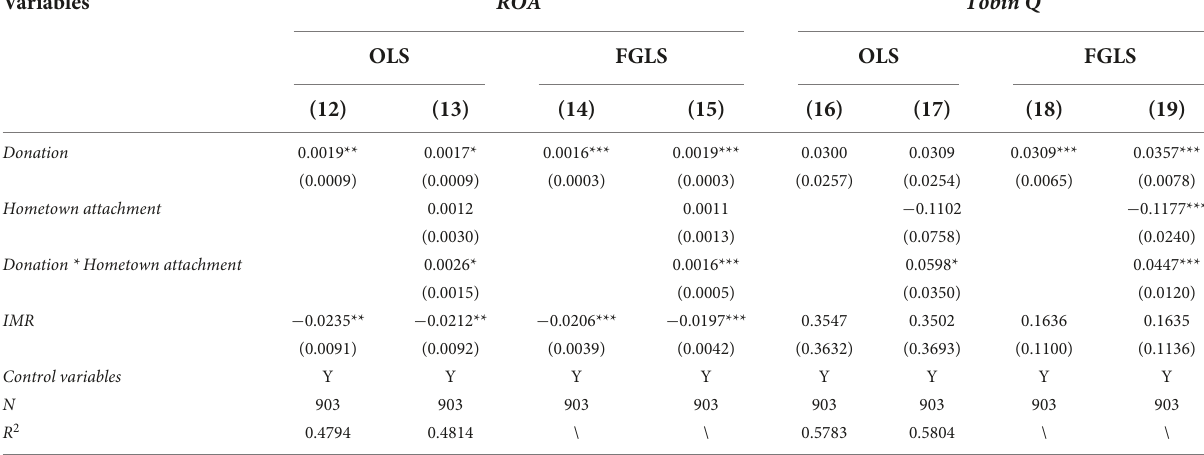
TABLE 11 Regression result of using T + 1 explanatory